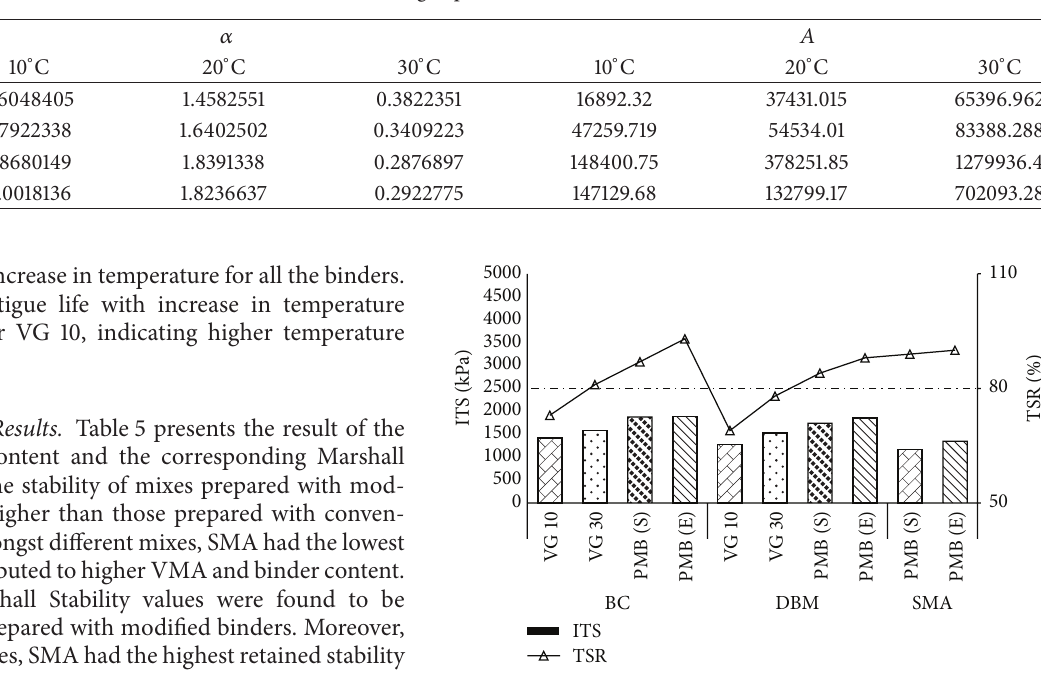
Figure 4: Variation of fatigue life with temperature at two different strain levels. Table 4: Values of fatigue parameters 𝛼 and 𝐴 .